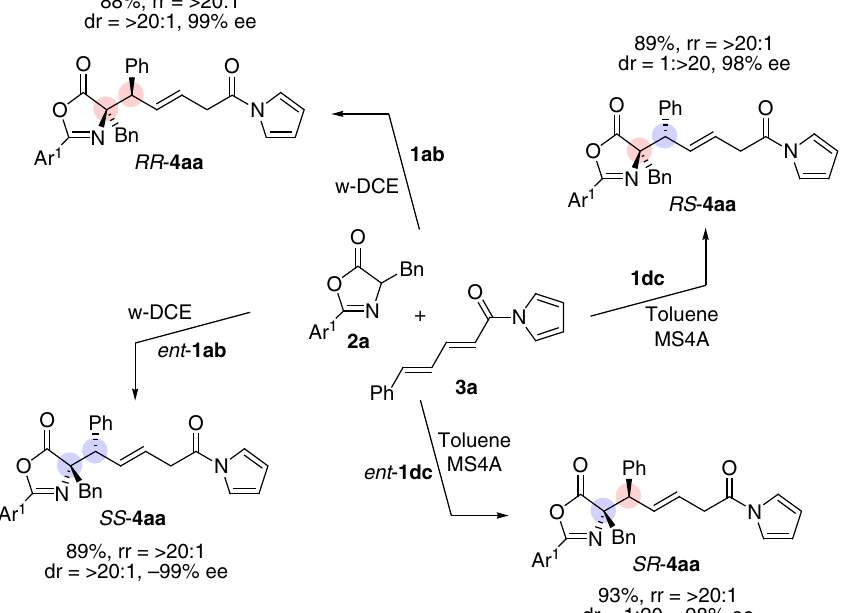
Figure 2 | Stereodivergent synthesis of all stereoisomers of 4aa (Ar 1 ¼ 2,6-(MeO) 2 C 6 H 3 ). All reactions were performed with 5mol% of 1 in the indicated solvent at (cid:2) 30 (cid:2) C for 16h.